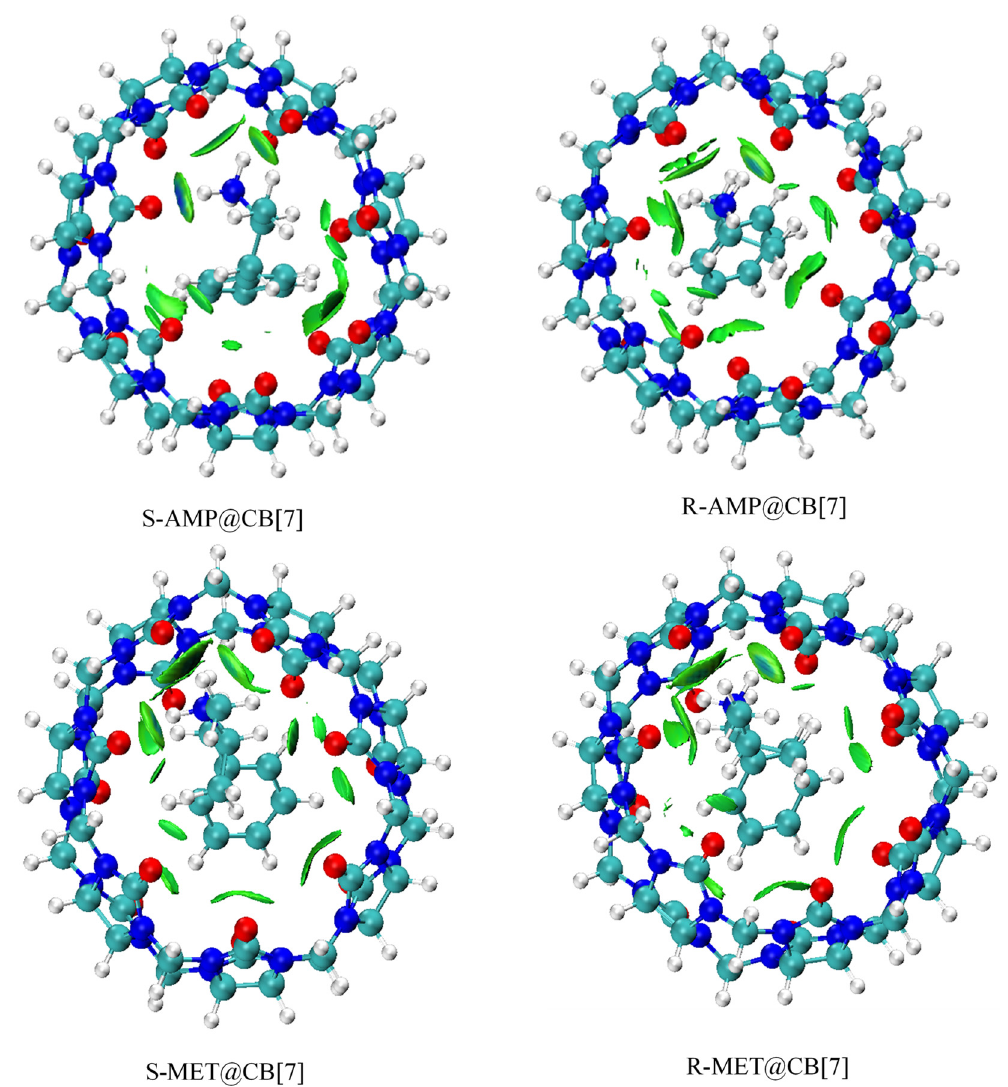
Figure 3. IGM isosurfaces plots (isovalue = 0.005 a.u.) of the studied complexes. Table 4. Calculated HOMO and LUMO energy levels (eV) and HOMO–LUMO energy gaps (eV)